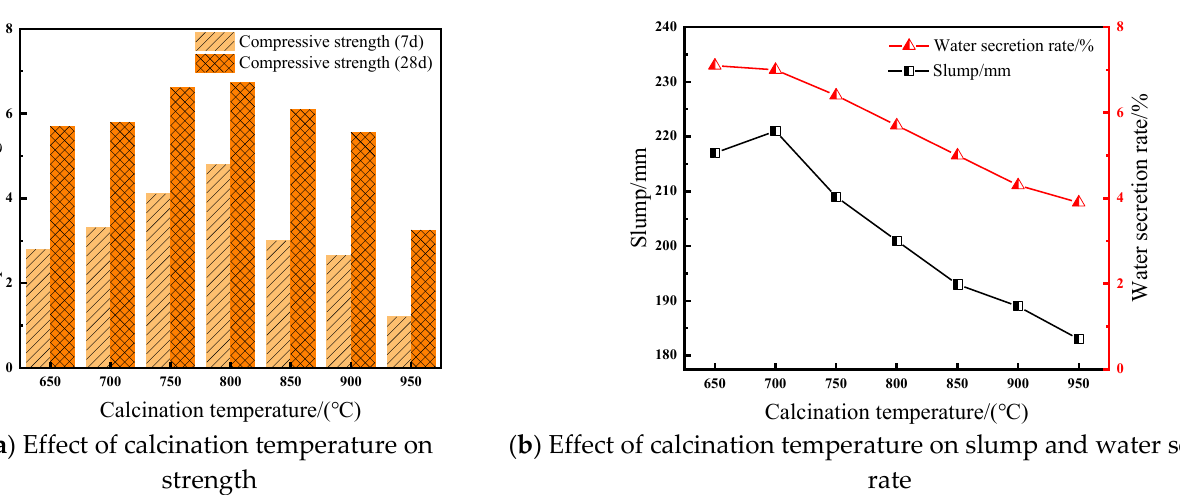
Figure 5. Effect of calcination temperature on CFTFM performance.